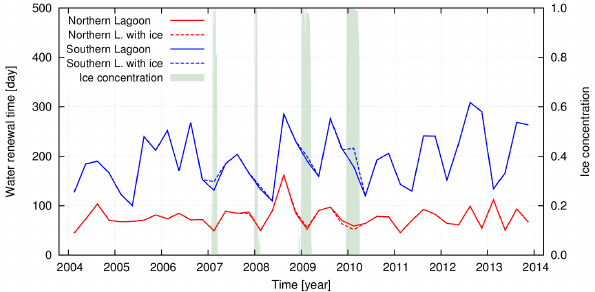
Figure 8. Water renewal times for the northern and southern basin. The WRT is computed every 3 months to obtain a seasonal estimate. WRT is computed with and without ice cover for the years 2007– 2010. The black curve shows the actual ice cover in the Curonian Lagoon.